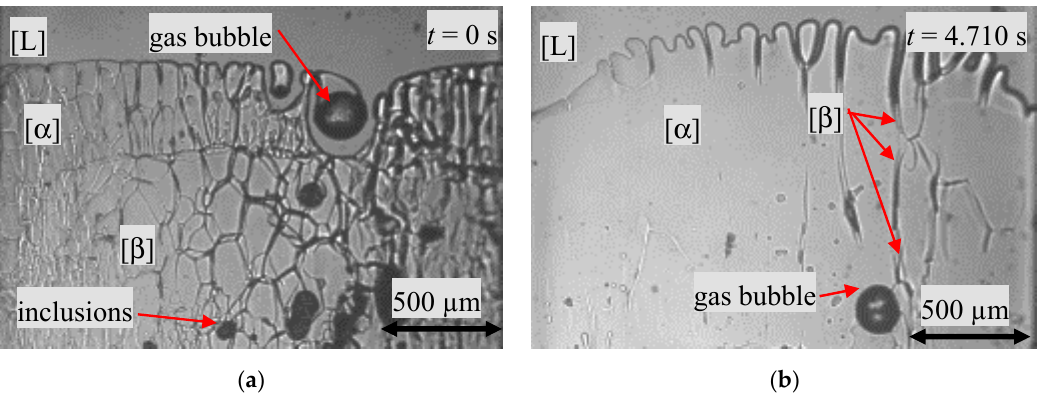
Figure 7. ( a ) The image of the sample shows the melt, two different solid phases, separated by a horizontal line, a gas bubble and various inclusions of NPG enrich melt. ( b ) Growth of the peritectic phase through small liquid channels across the α -phase toward the bulk liquid.